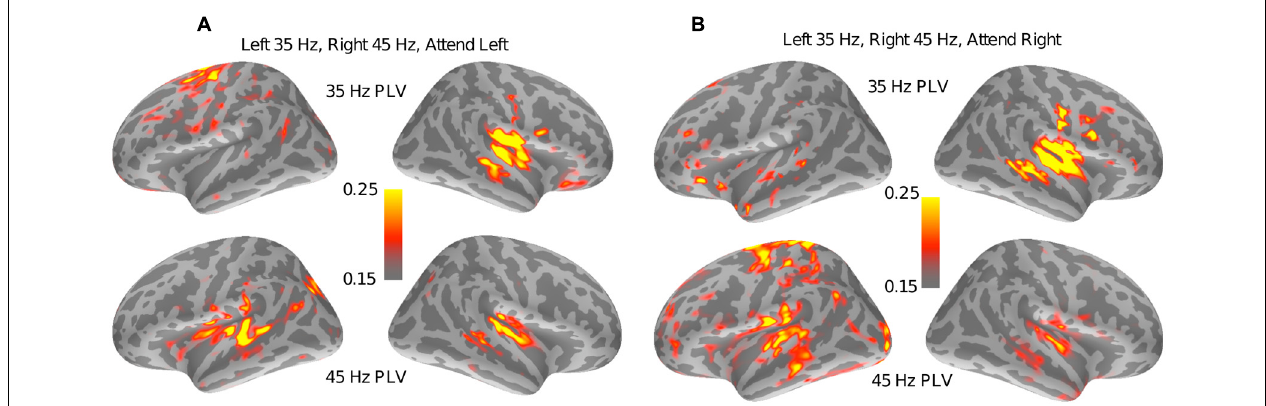
but not at 45 Hz. (B) PLV values for a stimulus that is identical to (A) , but with the subject now cued to attend to the stream modulated at 45 Hz. In this case, the superior left (but nor right)-precentral sulcus shows strong phase-locking at 45 Hz and not at 35 Hz. Taken together, the panels suggest that the left-precentral sulcus phase locks to the stimulus modulations in an attention-specific manner.